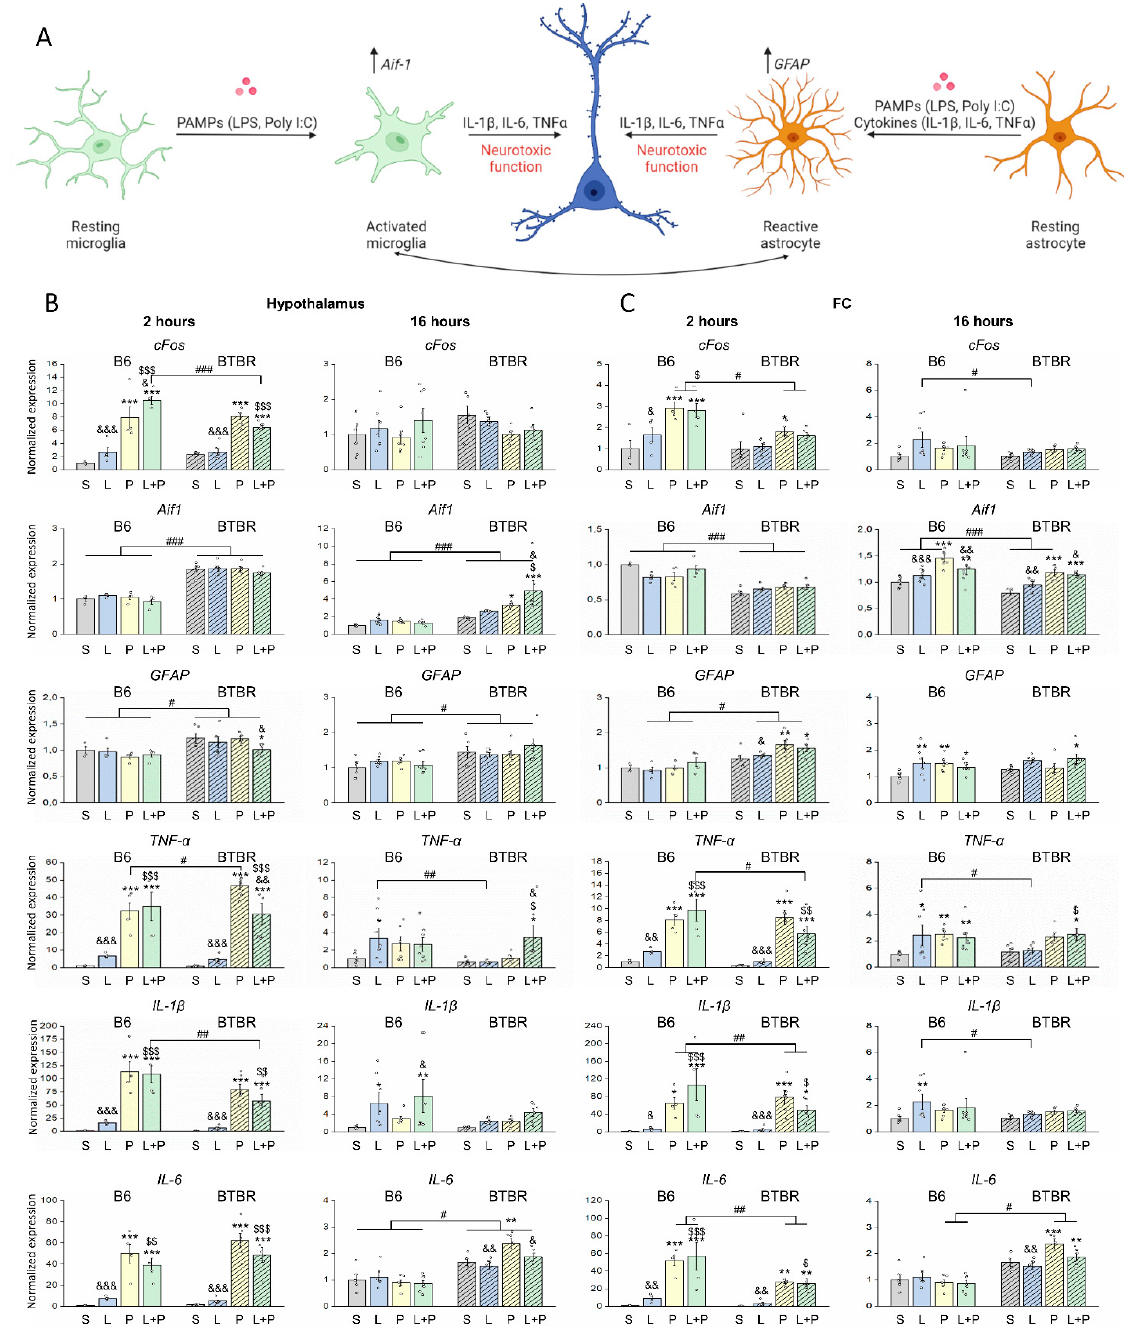
Figure 5. ( A ) The glial reaction to the acute inflammation; and ( B , C ) regional neuronal, microglial, and astrocyte activation markers and cytokines in the mouse brain after systemic injection of polyI:C (P), LPS (L), or their combination (L+P). The control group is marked as S (received saline). The mRNAs were quantitated by RT-PCR in the hypothalamus and prefrontal cortex (PFC) of B6 and BTBR mice. polyI:C and its combination with LPS significantly raised levels of cFos, allograft inflammatory factor 1 ( Aif1 ), glial fibrillary acidic protein Gfap, tumor necrosis factor ( Tnf ), interleukin-1 beta ( Il-1 β ), and interleukin-6 ( Il-6 ), mRNAs. Factorial ANOVA, mean ± SEM, n = 4–8 per group. * p < 0.05, ** p < 0.01, *** p < 0.001 as compared to saline control; $ p < 0.05, $$ p < 0.01, $$$ p < 0.001 in comparison with the LPS group; & p < 0.05, && p < 0.01, &&& p < 0.001 as compared to the polyI:C group; # p < 0.05, ## p < 0.01, ### p < 0.001 as compared to the corresponding B6 group according to Fisher’s LSD test as a post hoc